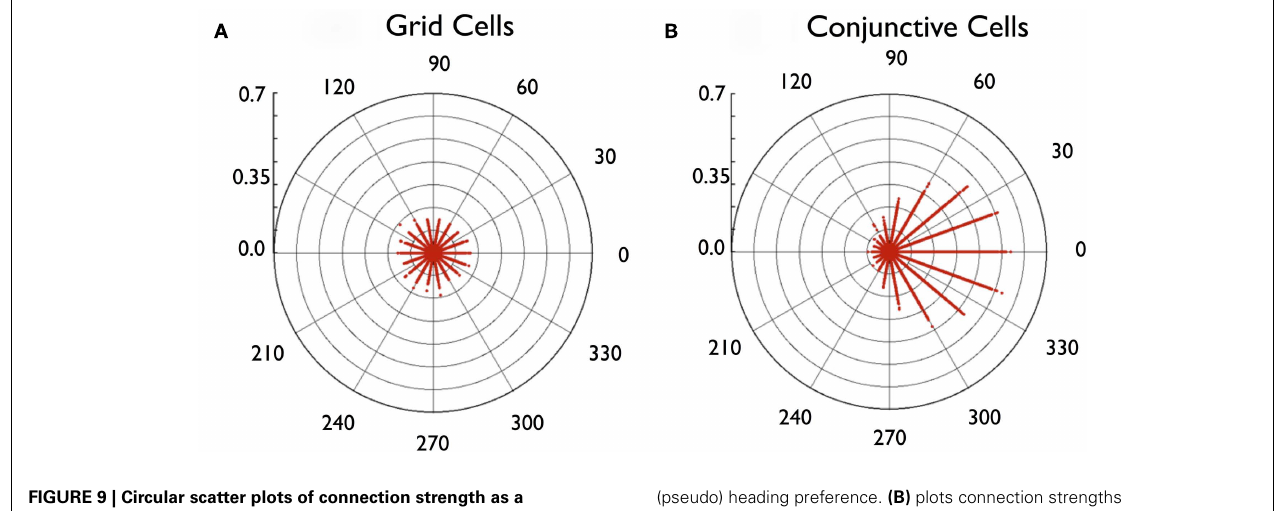
FIGURE 9 | Circular scatter plots of connection strength as a function of the difference in heading preference of the connected cells. (A) plots connection strengths between pairs of grid cells, where all values are low, and unmodulated by